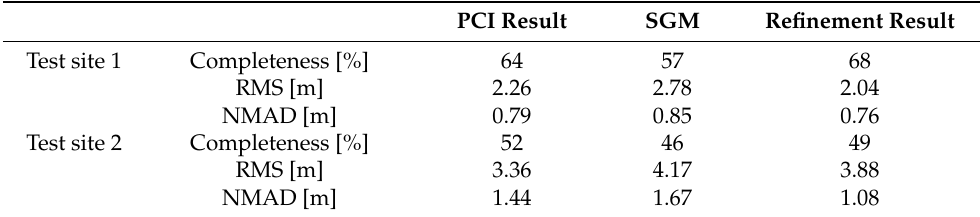
Table 2. Evaluation results for the test sites with the benchmark PCI and refinement